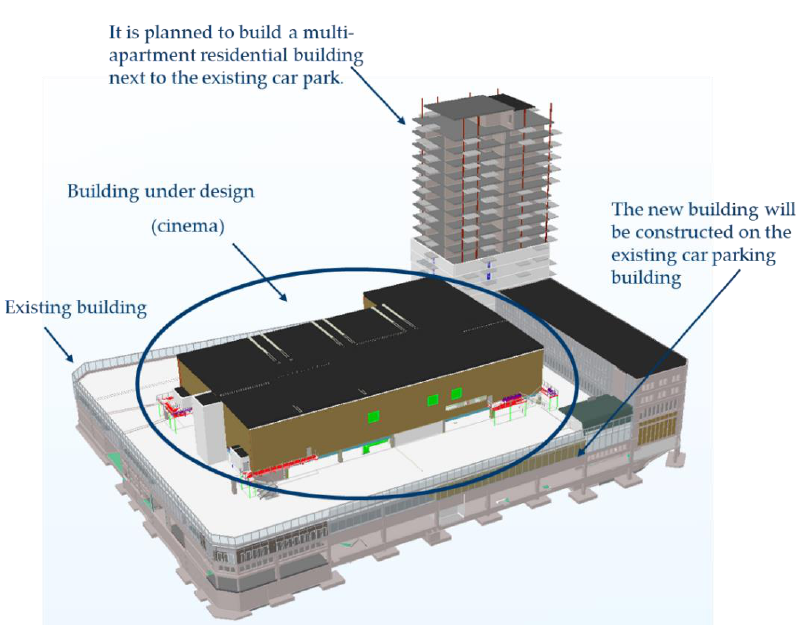
Figure 4. Structural model of the building under investigation.